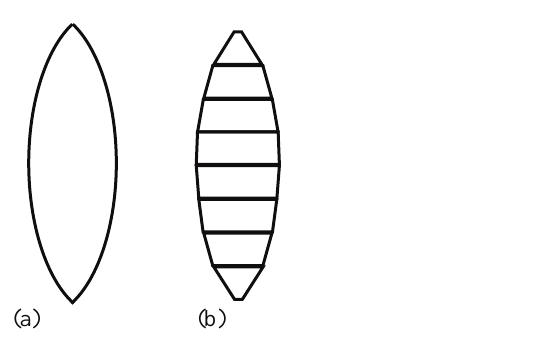
Figure 1 . Cross-section of a lens (a) modeled in terms of prisms (b).